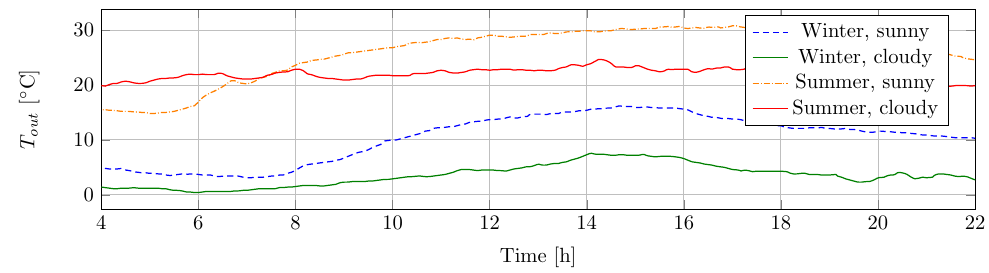
Figure 4. Outer temperature profiles for the four scenarios.